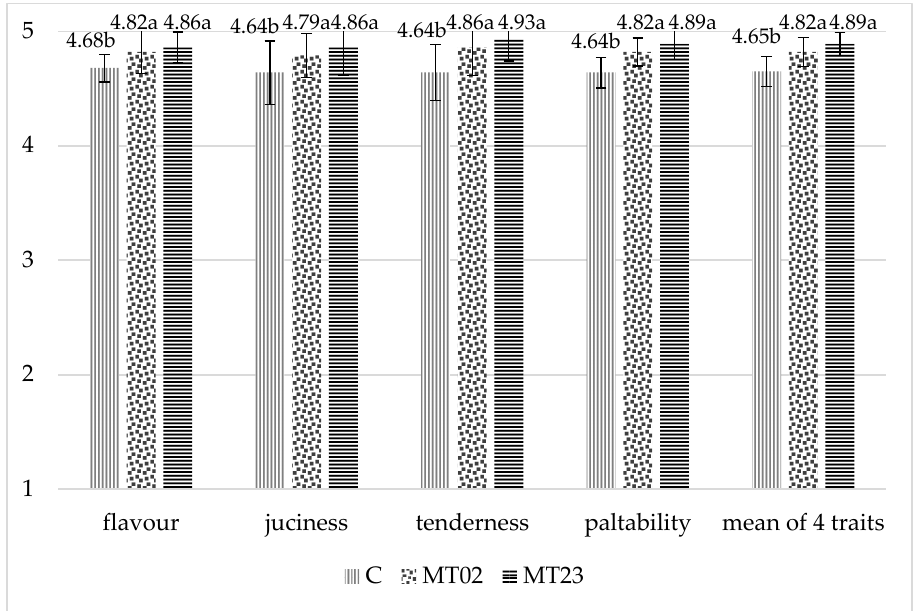
a row are significantly different at p ≤ 0.05.